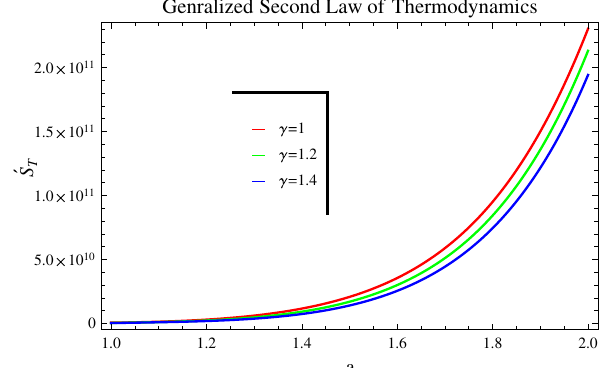
Fig. 7 Plot of (cid:10) versus a for power law corrected entropy using k = 1 , λ = − 1 , α = 1 , L p = 1 , r c = 1